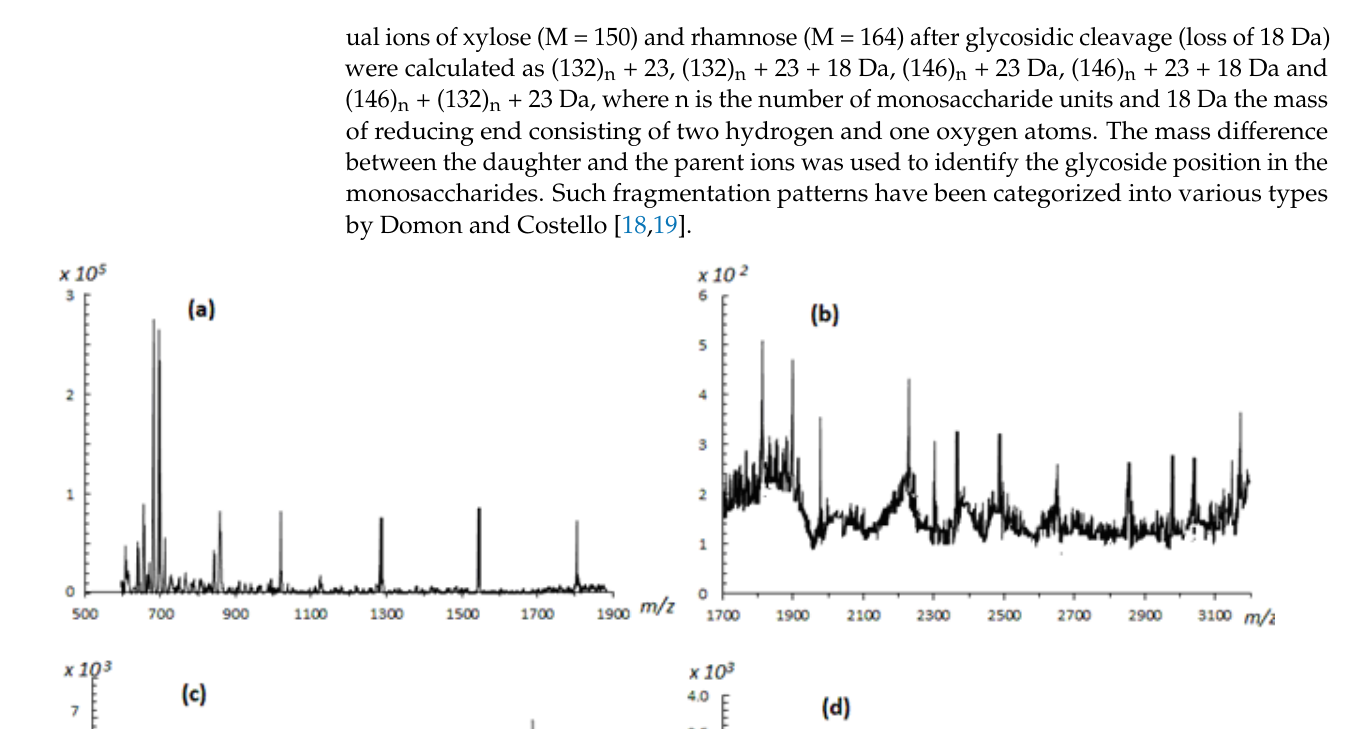
Figure 3. Structure of rhamnoxylan based on MALDI ‐ ToF mass spectral analysis.